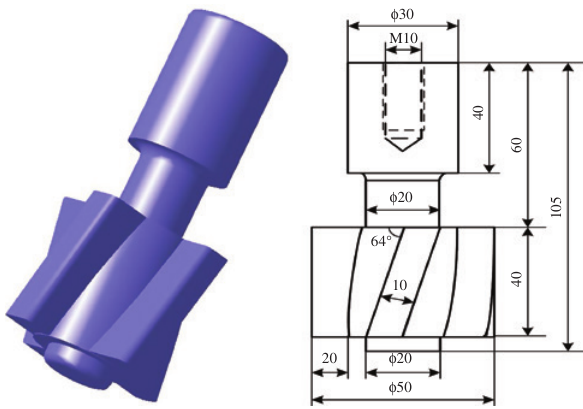
Figure 1: The schematic diagrams of graphitic agitator